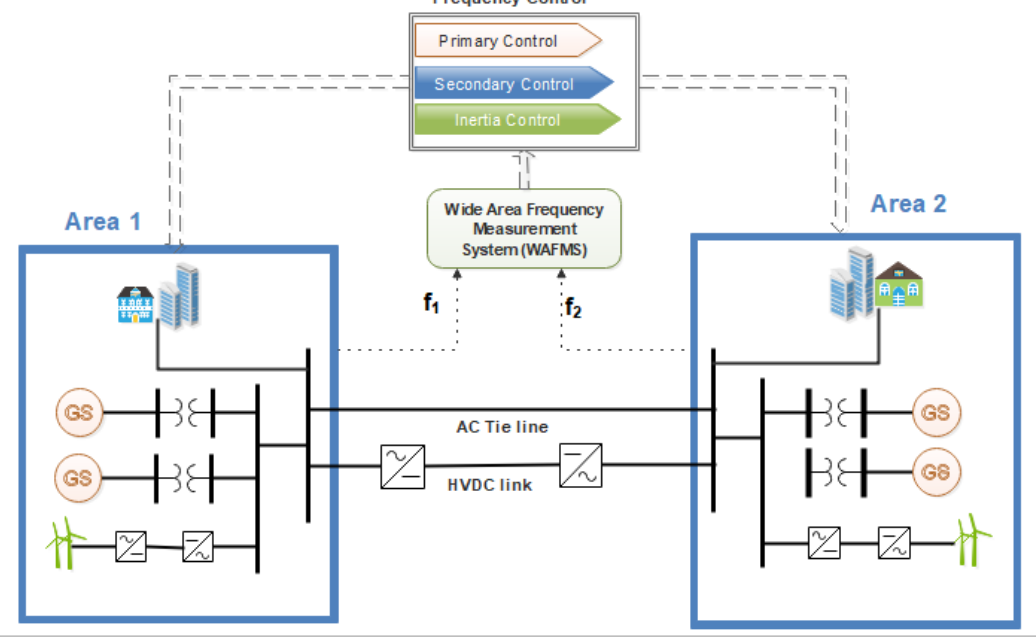
Figure 2. System